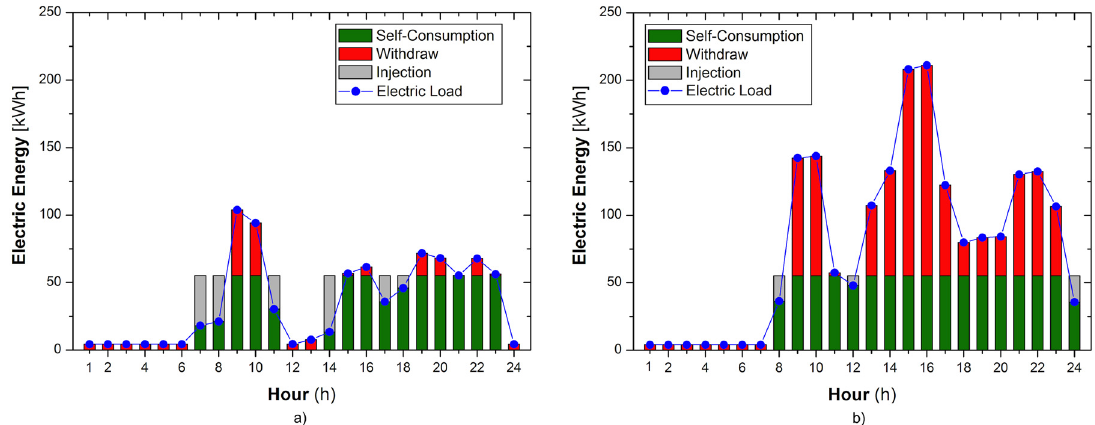
Figure 13. Hourly electric balance in winter ( a ) and summer ( b ) typical days. ORC electric production (self-consumption and electricity injected into the grid) and electric request of domestic users (with integration from the grid). ORC switch-off at 20% of nominal power.